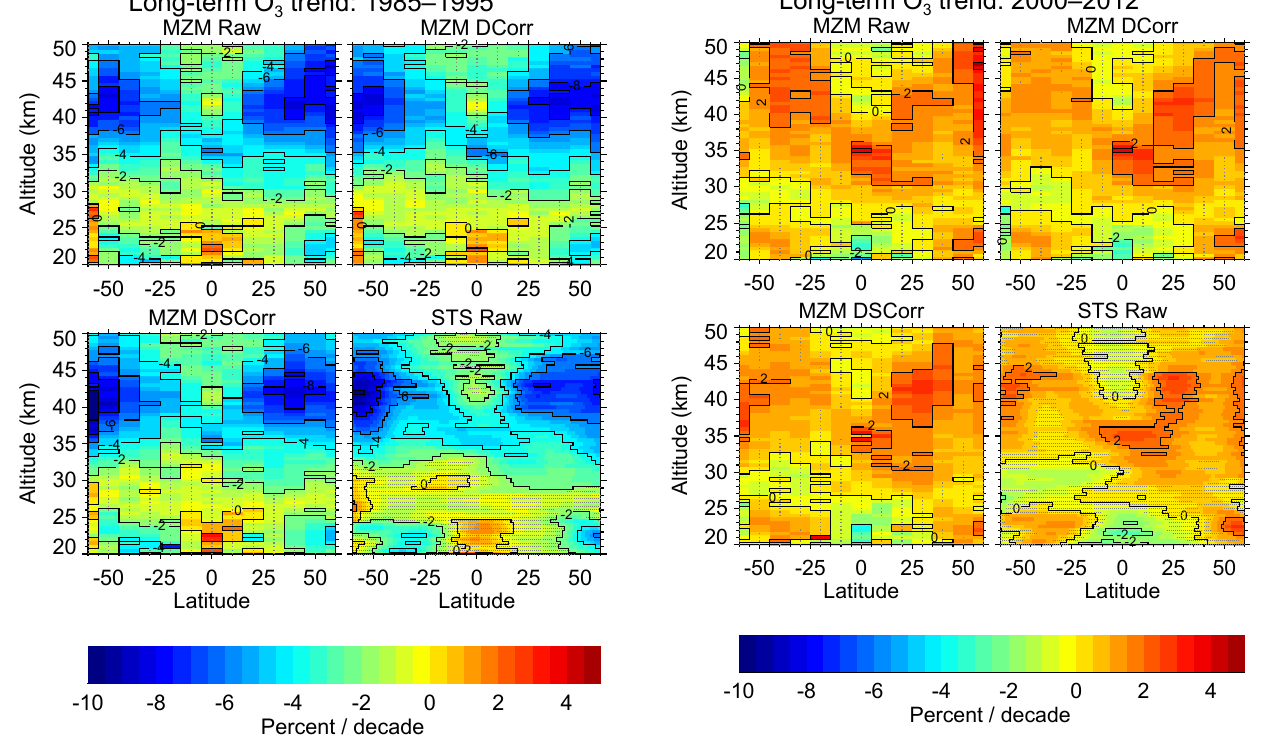
Figure 10. Long-term trends derived from both the MZM and the STS regressions during the typical decline period. Results are also shown when using the STS regression results to create a diur- nally corrected (DCorr) and a diurnally and seasonally corrected (DSCorr) data set for use with the MZM regression. The diurnal correction has the greatest influence on the upper stratosphere while the seasonal correction has the greatest influence at higher latitudes. Stippling denotes areas where the trend results are not significant at the 2 σ level. Contour lines are plotted at 2% intervals.